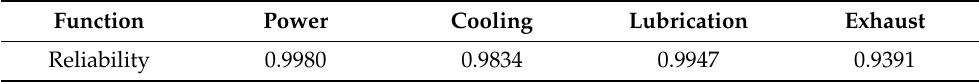
Table 2. Functional reliability of the diesel engine system. Function